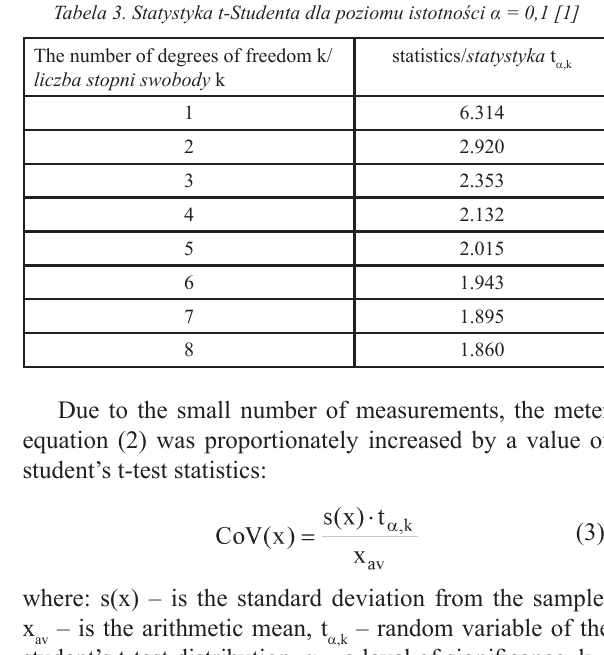
Table 3. Student’s t-test statistics for the significance level α = 0.1 [1] Tabela 3. Statystyka t-Studenta dla poziomu istotności α = 0,1 [1] The number of degrees of freedom k/ liczba stopni swobody k